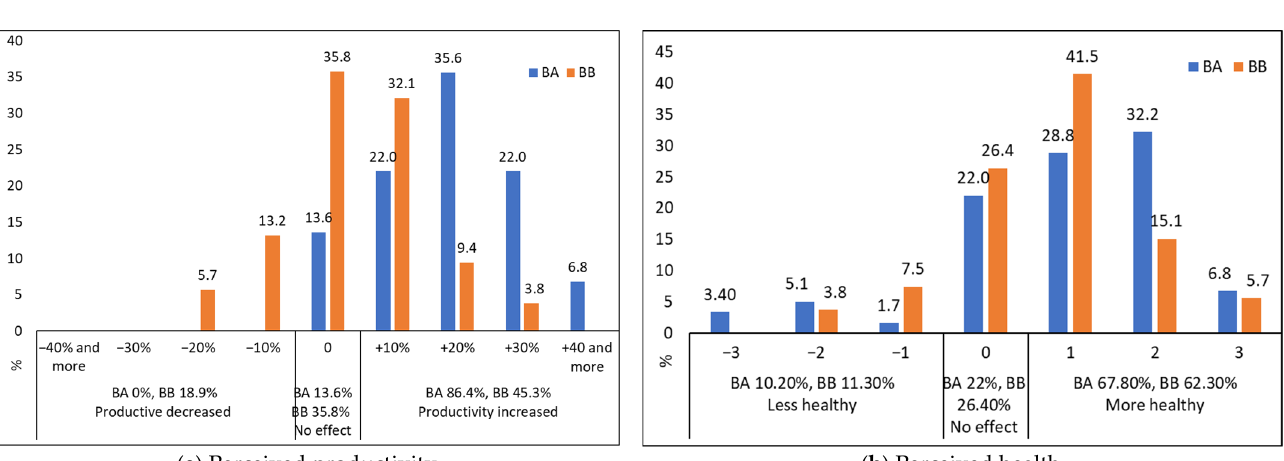
Figure 7. Frequency distribution of perceived health and productivity.